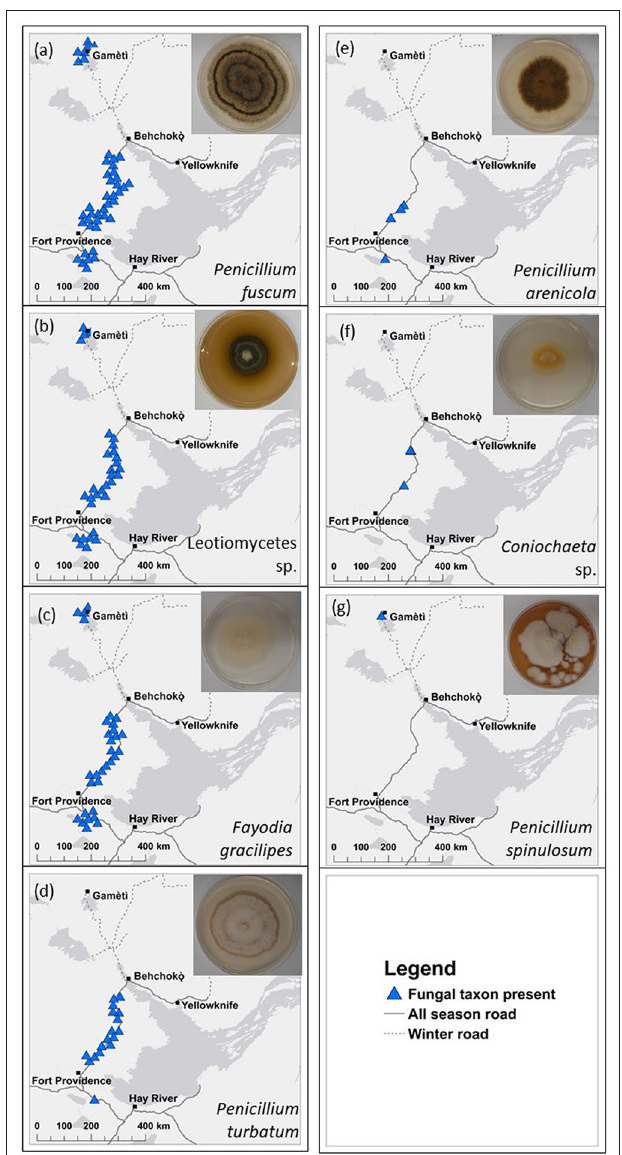
FIGURE 2 | Map of distributions of seven of heat-resistant fungal taxa across 47 plots in boreal forests in the Northwest Territories, Canada. Blue triangles show locations of (a) Penicillium fuscum , (b) Leotiomycetes sp., (c) Fayodia gracilipes , (d) P. turbatum , (e) P. arenicola , (f) Coniochaeta sp., and (g) P. spinulosum . Insets are photos of cultured fungi. Distribution information is based on matching Sanger sequences of the isolated heat-resistant fungal taxa with operational taxonomic units from high throughput sequencing (Illumina, MiSeq) sequences at 97% similarity. Points are jittered to reduce overlap but were at least 100m from the road. All 47 plots are shown in Figure 1 . Details of cultures are in Table S2 . There were three quadrats at each plot.